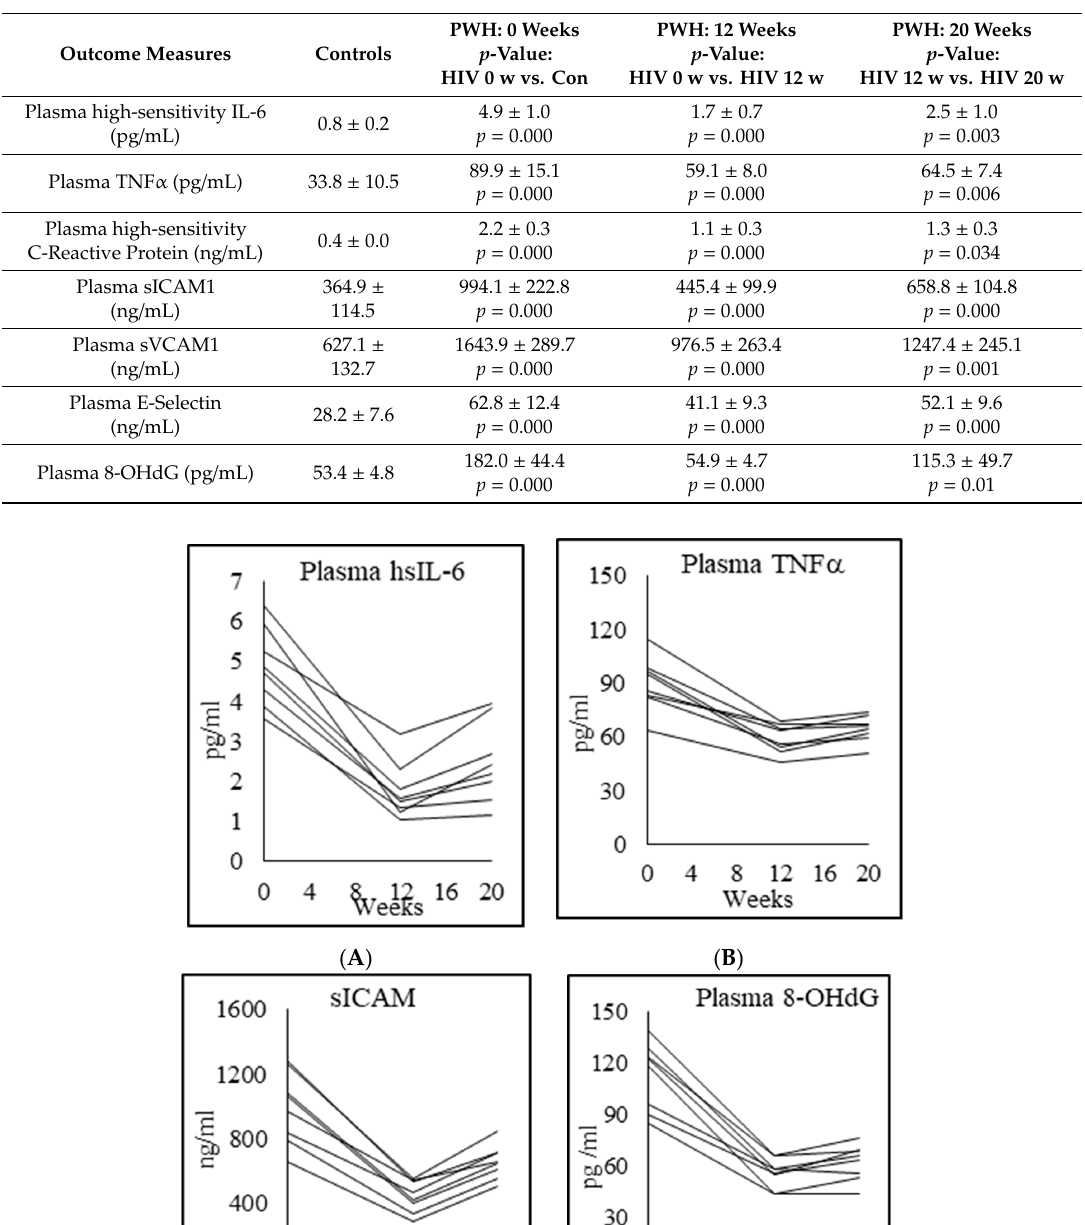
Table 5. Inflammation, endothelial function, and genotoxicity.